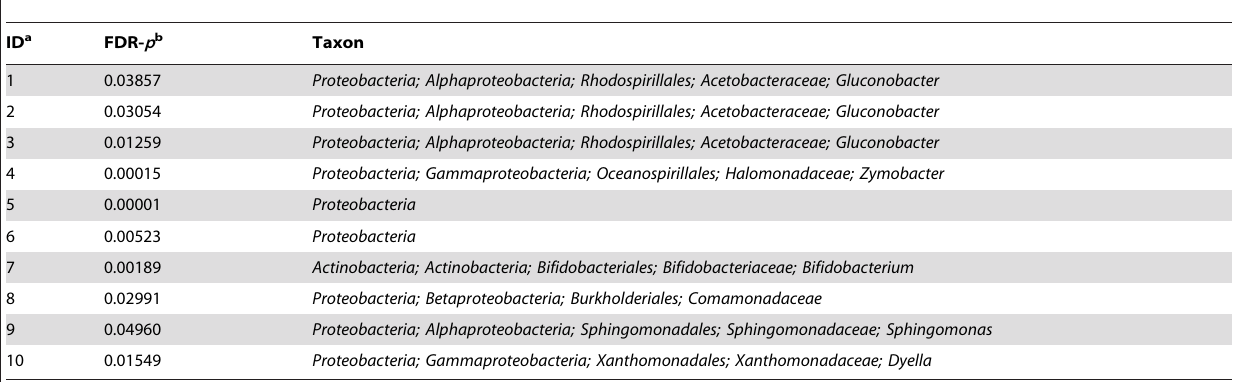
Table 1. ANOVA Significance of Inoculation-based Differences in Bacterial Taxa.